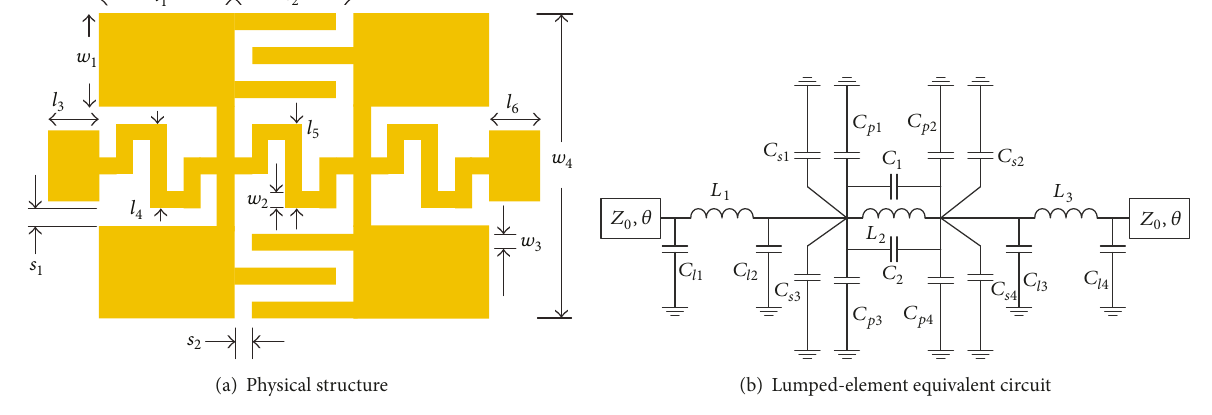
Figure 3: Unit cell of ATL.